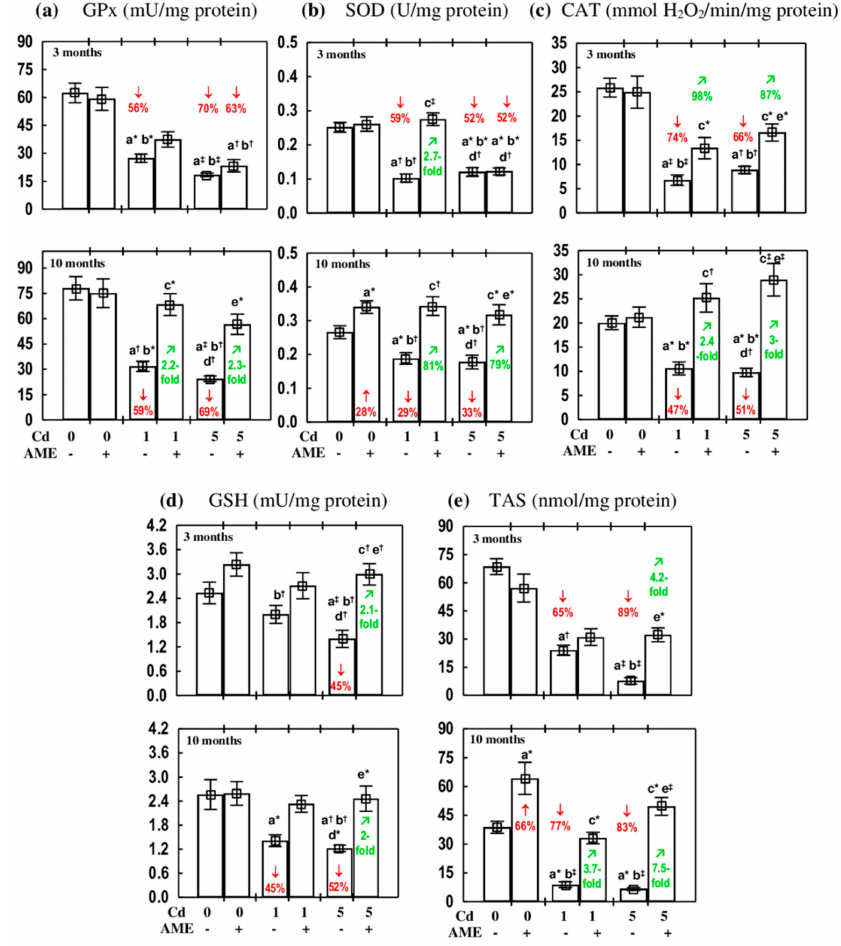
Figure 1. The e ff ect of the extract from Aronia melanocarpa L. berries (AME) on the markers of the antioxidative status of the submandibular gland of female rats exposed to cadmium (Cd). ( a ) glutathione peroxidase (GPx) activity; ( b ) superoxide dismutase (SOD) activity; ( c ) catalase (CAT) activity; ( d ) reduced glutathione (GSH) concentration; ( e ) total antioxidative status (TAS). The animals received cadmium in the diet at concentrations of 0, 1, and 5 mg Cd / kg and / or 0.1% aqueous AME ( + ) or not ( − ). Data are presented as mean ± SE for eight rats. Statistically significant di ff erences (Kruskal–Wallis post hoc test): a compared to the control group, b compared to the AME group, c compared to the Cd 1 group, d compared to the Cd 1 + AME group, e compared to the Cd 5 group, where * p < 0.05, † p < 0.01, and ‡ p < 0.001. Numerical values in bars or above the bars reveal the percentage changes or factors of changes in comparison to the respective control group ( ↓ , decrease; ↑ , increase;) or the appropriate group that received cadmium alone ( (cid:37) ,